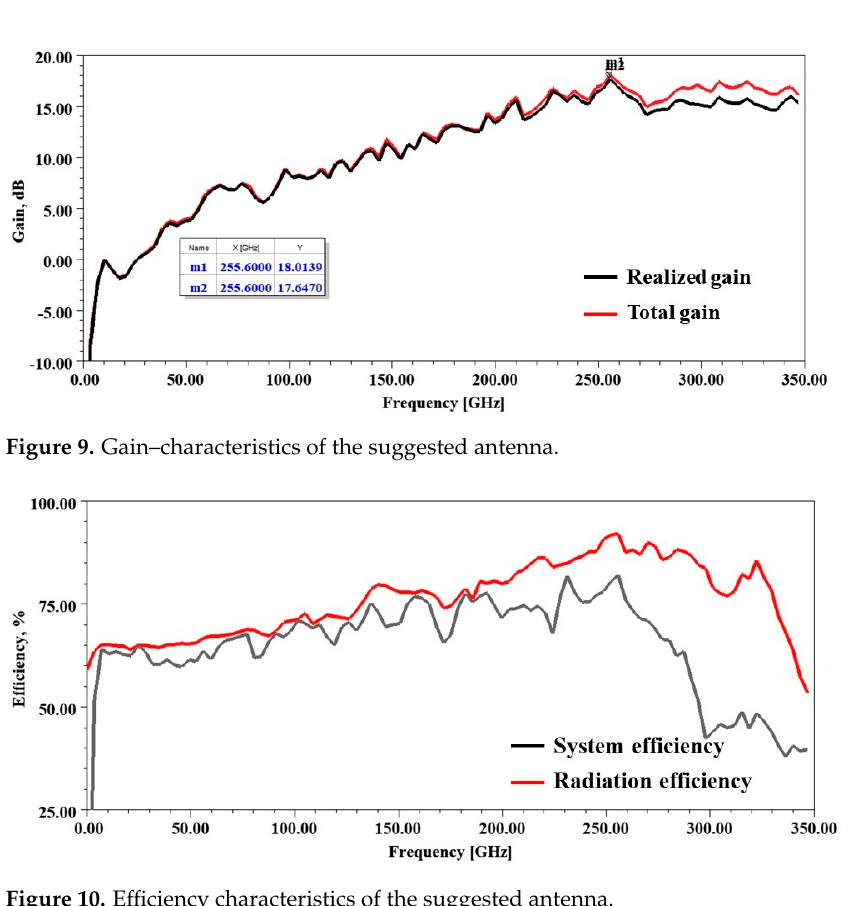
Figure 12. Simulated and measured return loss of the proposed SWB monopole antenna.